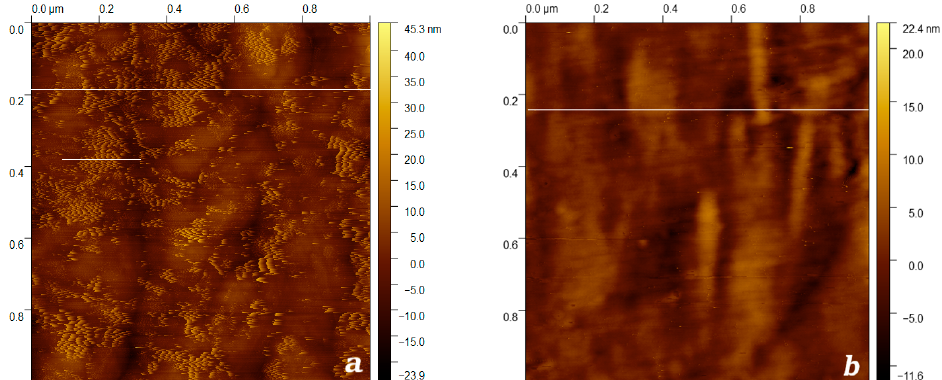
Figure 6. Topographic image of the surface of thermoradiationally modified polytetrafluoroethylene films before ( a ) and after ( b ) treatment with accelerated xenon ions to a fluence of ~10 8 cm − 2 , established by atomic force microscopy (white lines highlight the measurement areas of the surface profile).